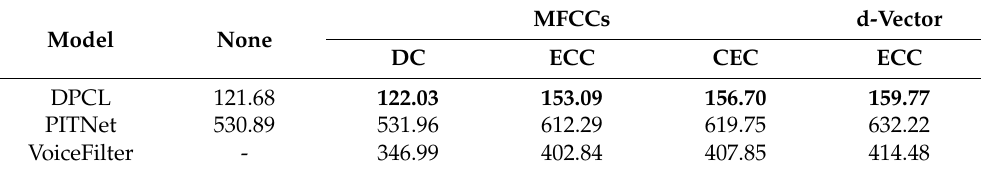
Table 4. Model sizes of the proposed methods (unit: